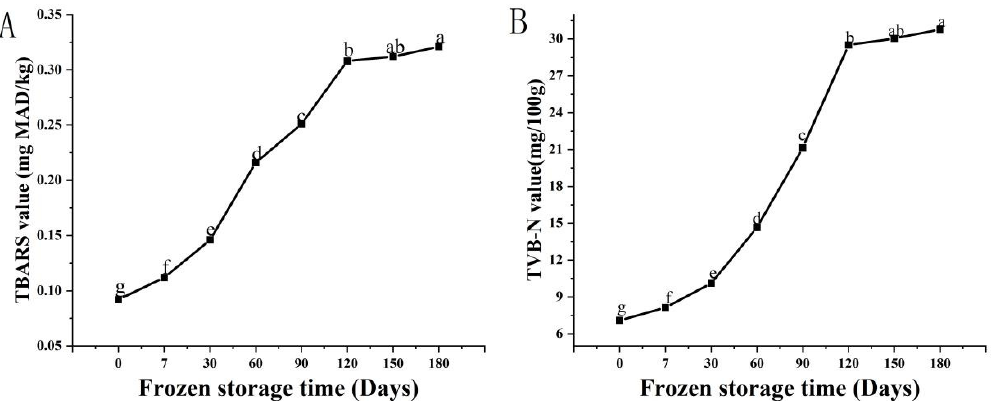
Figure 5. Changes in Thiobarbituric acid reactive substances (TBARS) value ( A ) and total volatile base nitrogen (TVB-N) value ( B ) of fish sausages during frozen storage. Significant differences between samples ( p < 0.05) are denoted by lowercase letters.